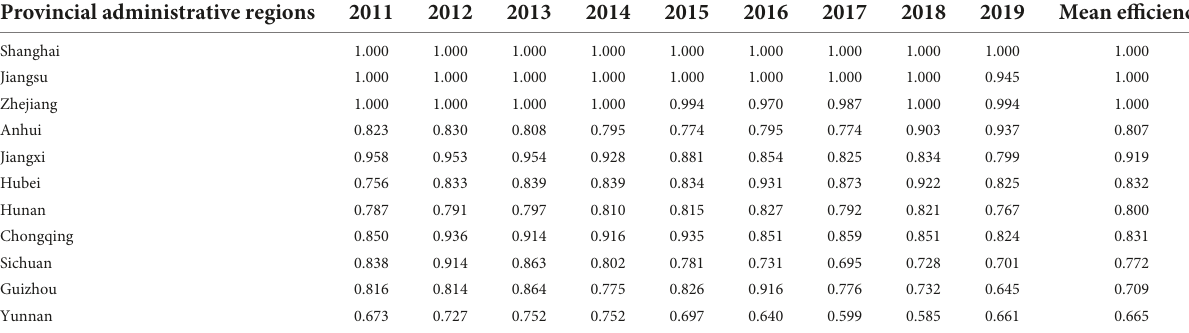
TABLE 2 Input–output efficiency of the WEF nexus of the Yangtze River Economic Belt. Provincial administrative